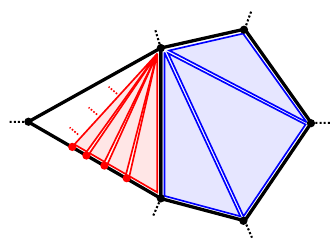
Figure 7 . Illustrative example of an in(cid:12)nitely redundantly triangulated cone. We draw a simplicial cone of a 3-dimensional fan intersected with the unit sphere S 2 . The cones and the redundant rays from the in(cid:12)nitely redundant triangulation are drawn in red, the non-redundant triangulation in